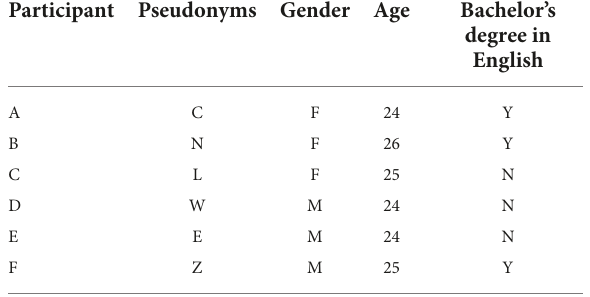
TABLE 1 Biographical information of the